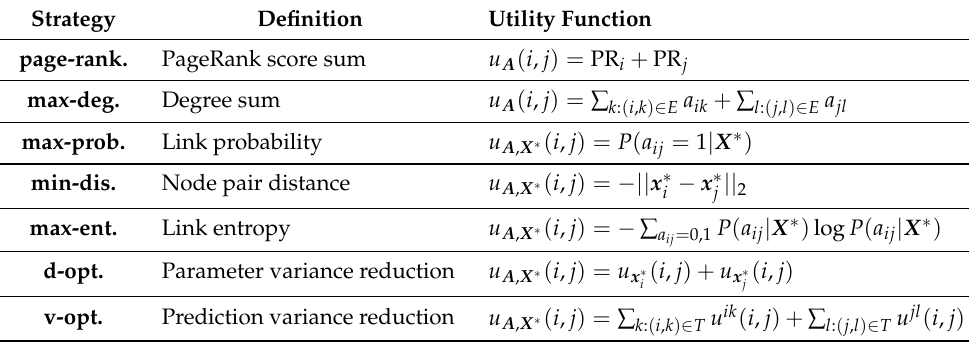
Table 2. Summary of the query strategies for